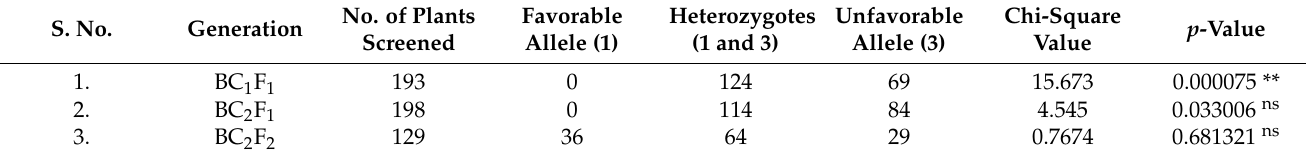
Table 1. Segregating pattern of crtRB1 allele in the BC 2 F 2 population of CAUM66 × UMI285 β +